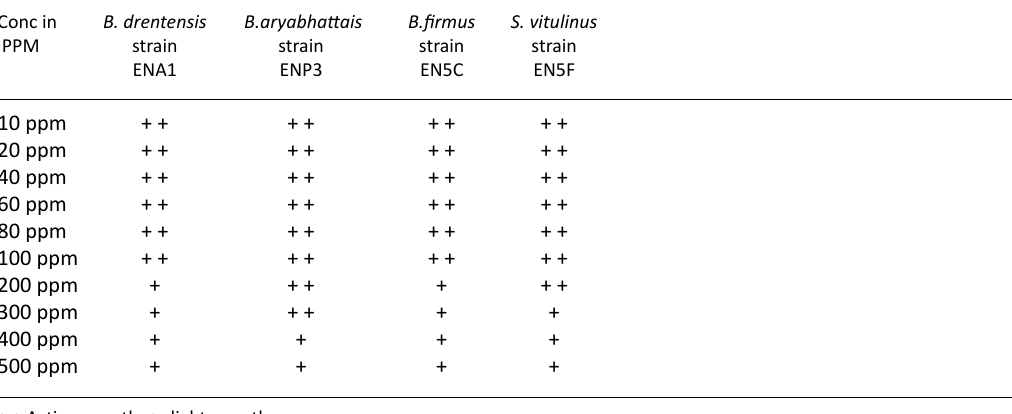
Table 3. Tolerance of Monocrotophos concentration by the four isolates Conc